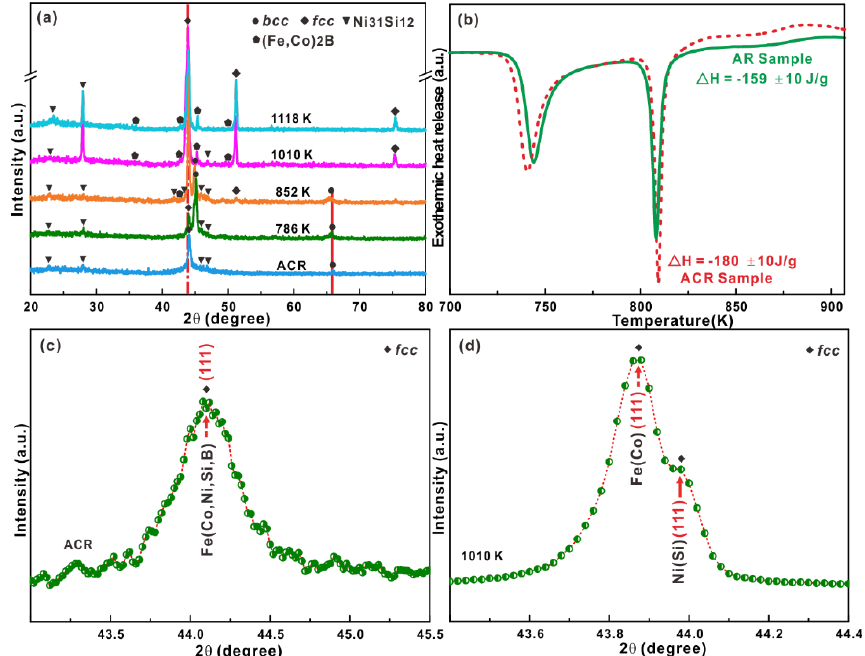
Figure 5. ( a ) XRD patterns of the melt-spun ACR ribbons and samples heated to different temperatures, ( b ) DSC curves of the AR and ACR samples, ( c ) the diffraction peak of the FCC phase along the zone axis (111) for the as-cast ACR sample (taken from Figure 5a), and ( d ) the diffraction peaks of two type of FCC phases along the zone axis (111) for the ACR sample heated to 1010 K (taken from Figure 5a).